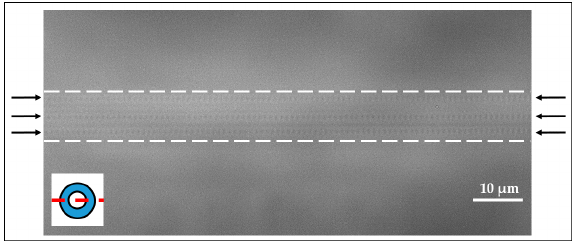
Figure 5. Microscopic image of part of a fiber including three FBGs in the fiber core next to each other. The gratings consisted of different pitch distances (different grating periods), so that all FBGs can be observed simultaneously. The black arrows indicate the positions of the individual gratings. The dashed lines illustrate the core ‐ cladding ‐ interface. The inset indicates the optical section plane.